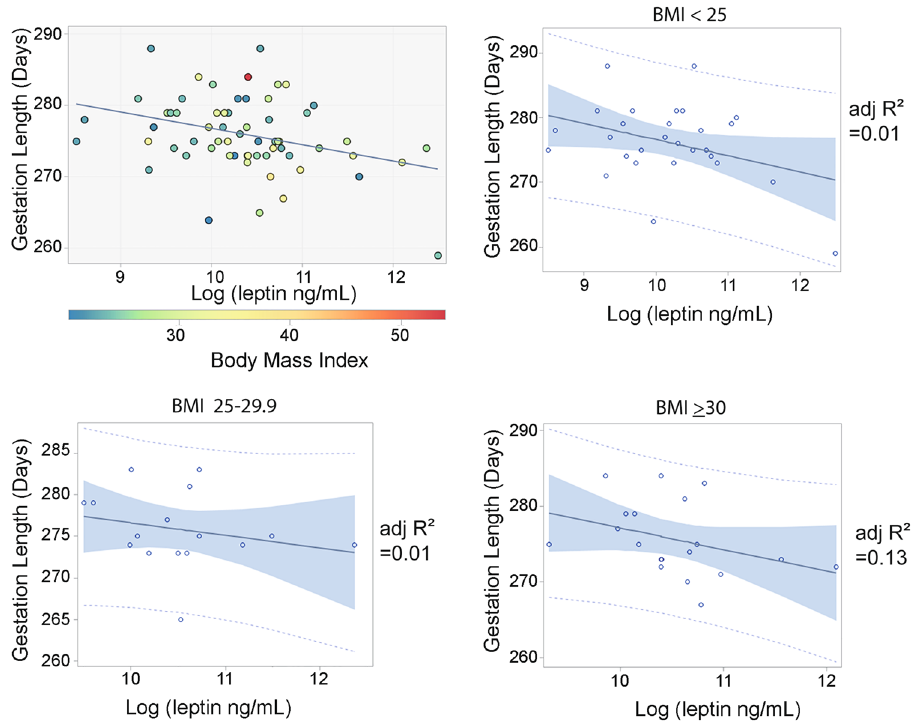
Figure 3. ( a ) Relationship between mid-gestation serum leptin concentrations and total gestation length in days. Leptin concentrations are log-transformed to achieve a normal distribution. For each individual, BMI is indicated by marker color. Gestation length is significantly related to log leptin ( p = 0.01) ( b ) Relationship between serum leptin concentrations and length of gestation for individuals with BMI < 25 ( c ) Relationship between serum leptin concentrations and length of gestation for individuals with BMI 25–29.9 ( d ) Relationship between serum leptin concentrations and length of gestation for individuals with BMI > 30. Each circle represents a single observation, the solid line is the linear regression, and the shaded area indicates the 95% confidence